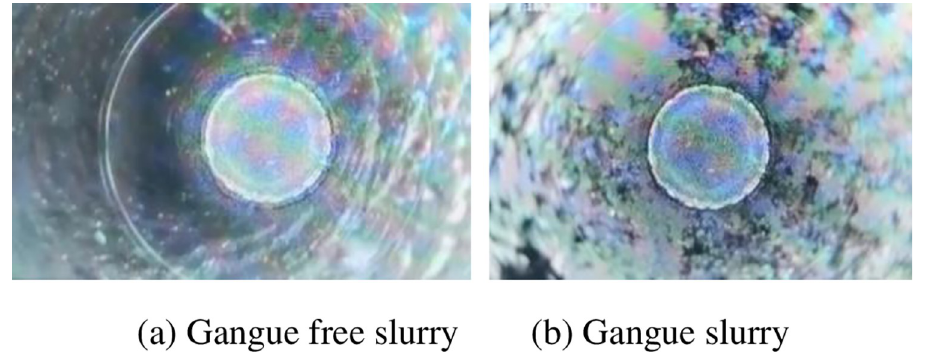
Fig 12. Bored peeking pictures. (a) Gangue free slurry. (b) Gangue